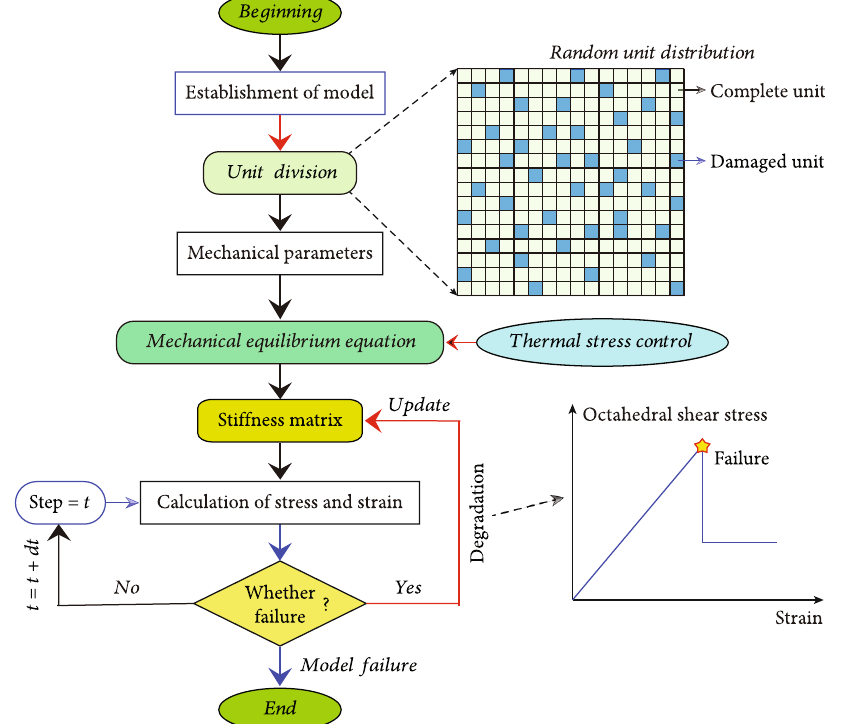
Figure 2: Flow chart of numerical simulation solution. Table 1: Numerical model parameters.